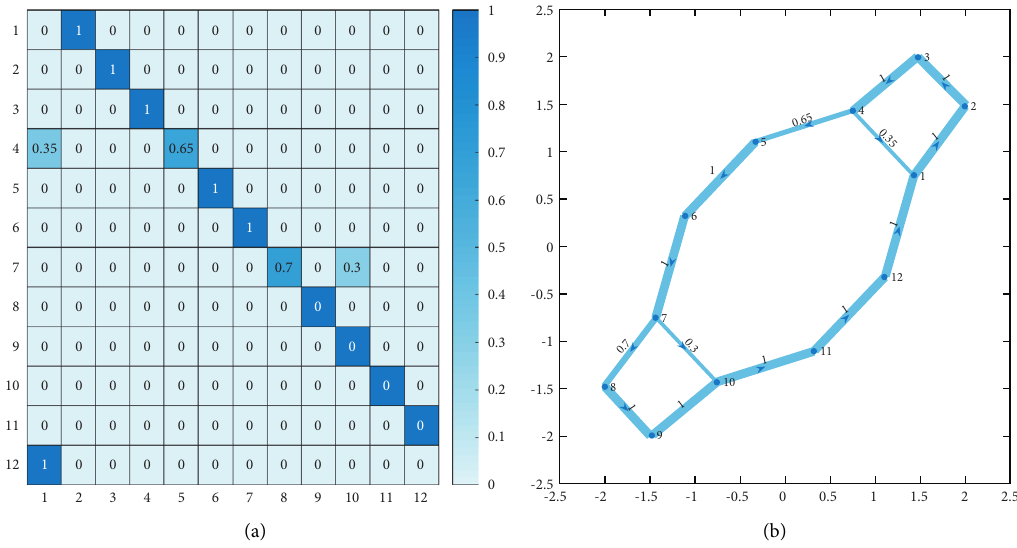
Figure 4: The transitional probabilities (a) and the directional graph (b) of the first-order Markov chain.